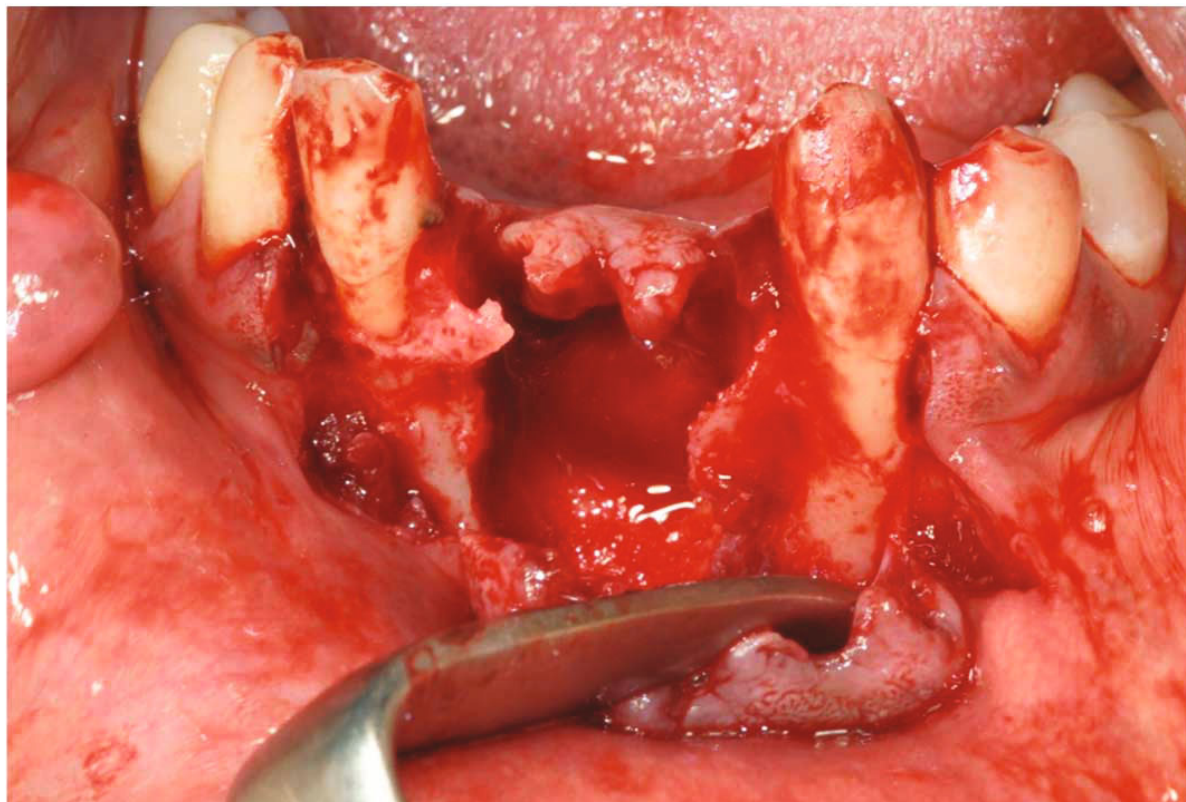
Figure 3: Bone defect after tooth extractions and cyst removal.